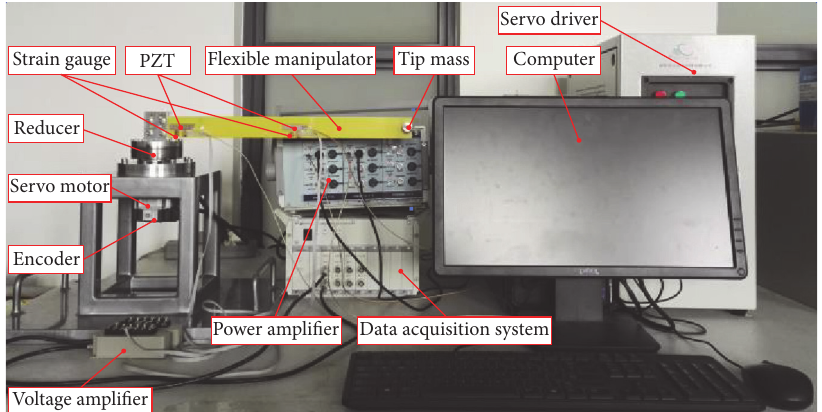
Figure 12: Photograph of the experimental apparatus.